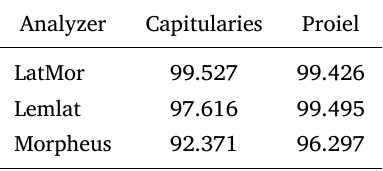
Coverage of morphological